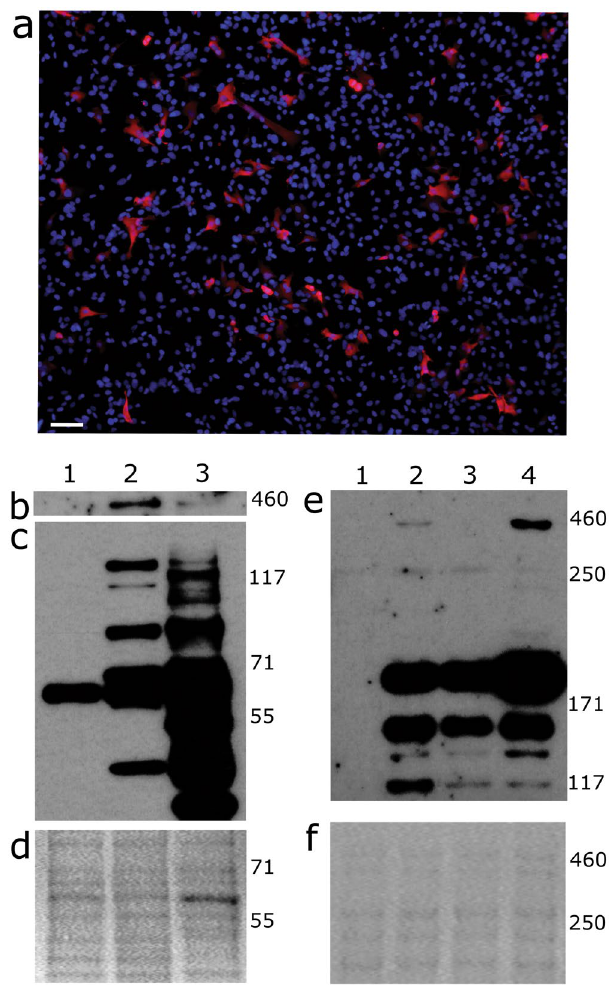
Figure 5. Full-length dystrophin expression in transduced HT1080 cells. Vectors DDF-PGK-coDys-oPRE and DDF-SFFV-coDys-oPRE were applied to HT1080 cells at an MOI of 2. ( a ) Cells transduced with DDF- SFFV-coDys-oPRE were analysed for dystrophin expression (red) by immunofluorescence. Nuclei were stained with DAPI (blue). Scale bar = 50 µ m. ( b – d ) HT1080 cell lysates were analysed by Western blot for dystrophin expression. Lanes: 1, untransduced; 2, transduced with DDF-PGK-coDys-oPRE; 3, transduced with DDF- SFFV-coDys-oPRE. ( b ) Specific signal was detected near the 460 kDa marker following a long exposure period. ( c ) Lower molecular weight bands were detected following shorter exposure time. Full-length blot shown in Fig. S6d. ( d ) Ponceau S staining served as a loading control. ( e ) Lysates from consecutive passages of the DDF-PGK-coDys-oPRE transduced cells were analysed by Western blot for dystrophin expression. Lanes: 1, untransduced; 2–4 are lysates taken from the same transduced HT1080 cells after 1, 2 and 3 passages post- transduction, respectively. Full-length blot shown in Fig. S6e. ( f ) Ponceau S stain served as a loading